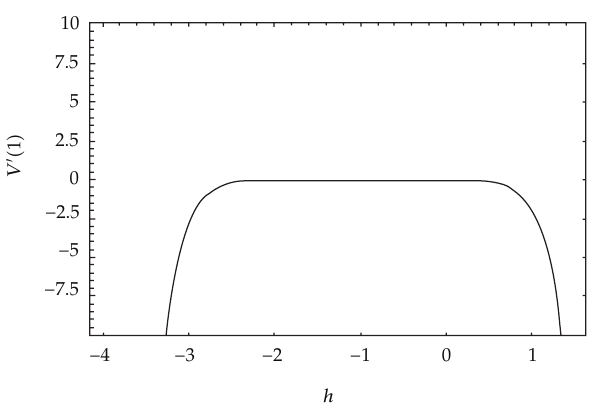
Figure 1: ħ -curve for velocity in case of constant viscosity at 10th-order approximation.